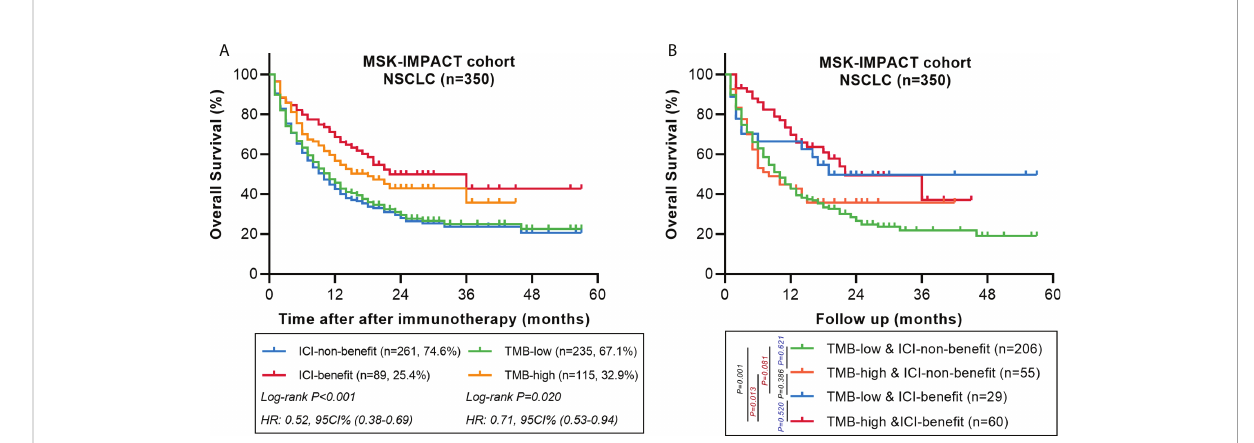
FIGURE 7 Comparing the predictive powers of ML-signature vs . TMB in patients treated with immunotherapy in the MSK-IMPACT cohort. (A) Overall survival of MSK-TMB patients with between ML-signature and TMB subgroups. (B) Overall survival of MSK-IMPACT patients with TMB-high and TMB-low further strati fi ed according to groups strati fi ed by